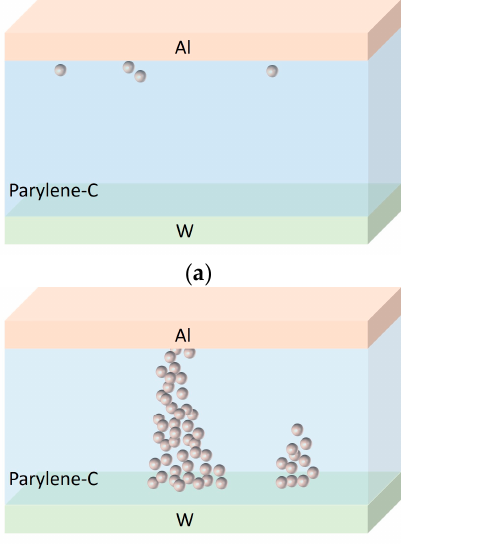
Figure 3. ( a ) The I-V curve with log-log scale from the set process. The low-resistance state (LRS) follows an ohmic conduction and the high-resistance state (HRS) follows a space-charge limited conduction (SCLC); ( b ) Current map of the fabricated conductive atomic force microscopy (CAFM) samples with an inert Pt electrode.